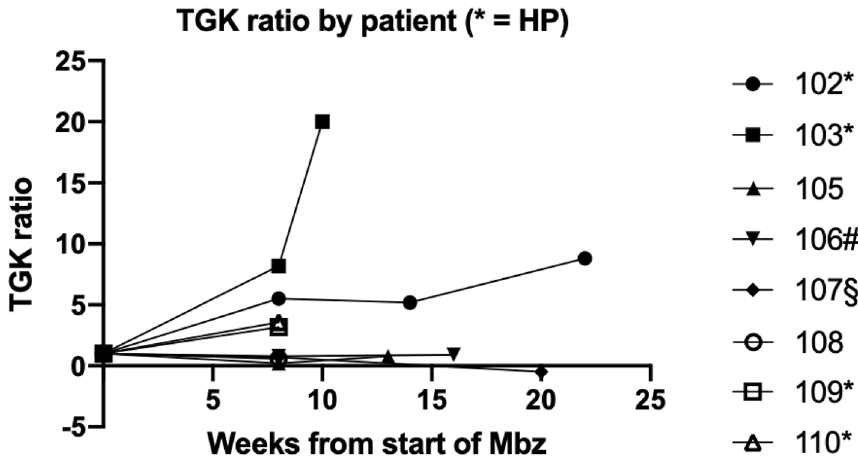
Figure 2. Graphical presentation of tumour growth kinetics (TGK) ratios during and after (as applicable) treatment with mebendazole (Mbz) for the radiologically evaluable patients. The TGK ratio pre-baseline was set to 1. TGK ratios were calculated by dividing the TGK from start of Mbz to w 8 on Mbz treatment, from w 8 to next radiological assessments and from this to the last assessment (patient 102), respectively, with the TGK pre-baseline. Pre-baseline TGK was calculated from CT scans while pts 103 and 106 were on chemotherapy whereas the remaining pts had no treatment. At post Mbz assessment patient 107 had restarted chemotherapy showed tumour regression as indicated by the negative TGK ratio. *Indicates patients fulfilling criteria for hyperprogression (HP) while on Mbz. # This patient continued Mbz from week 8 to next radiological assessment. § This patient had restarted chemotherapy from week 8 to next radiological